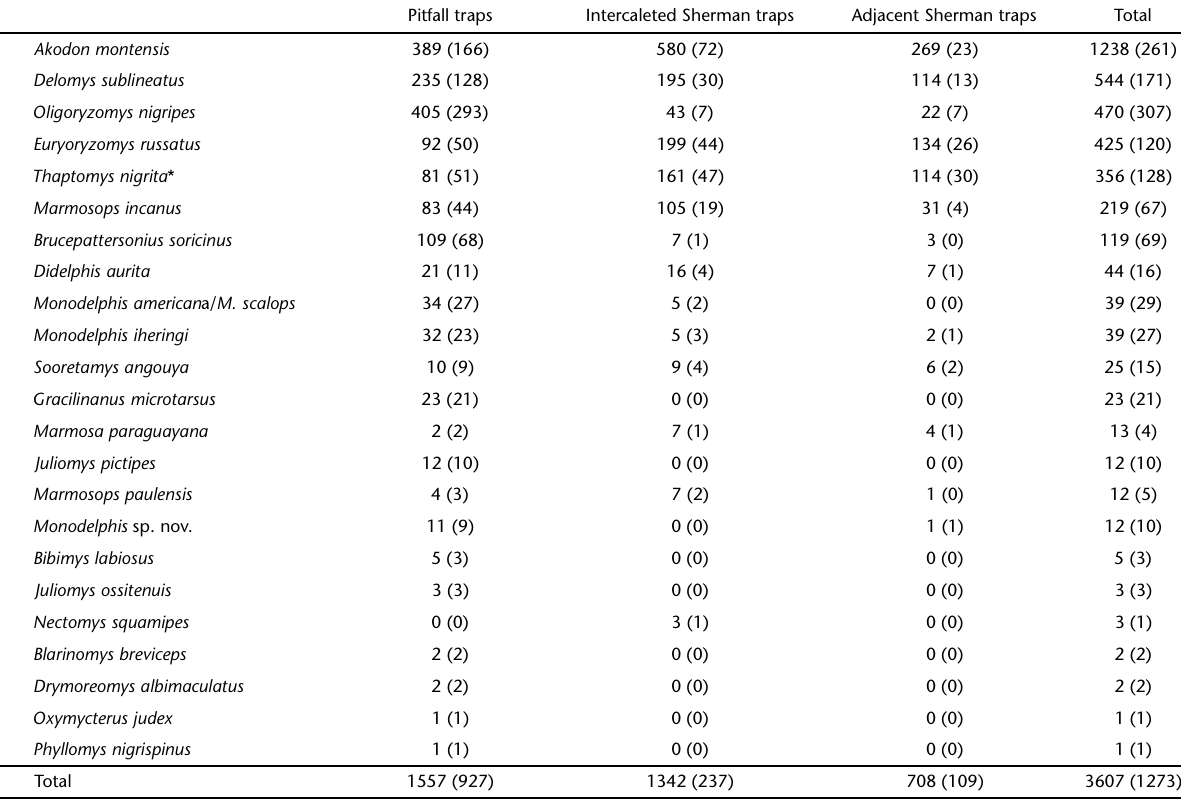
Table 1. Number of captures and number of individuals (in parentheses) obtained in each type of trap and in total for each small mammal species from the Morro Grande Forest Reserve. Numbers for pitfall traps are from the set of five trap lines per grid, and for Sherman traps are from the set of five trap lines per grid intercalated with pitfall lines or from the set of five trap lines per grid adjacent to pitfall traps. Due to the impossibility to separate the cryptic species Monodelphis americana and M. scalops in the field, individuals from both species were considered